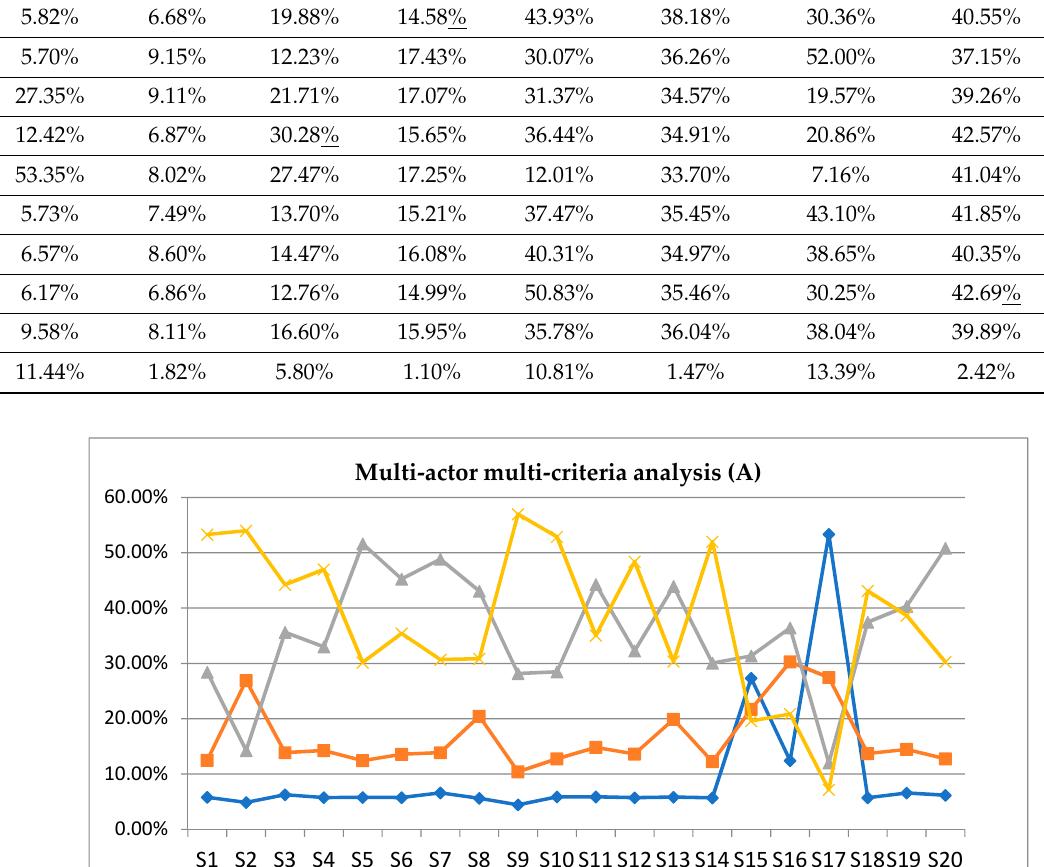
Table 5. Differences in results of MAMCA (A) and MAMCA with stakeholder weights (B).